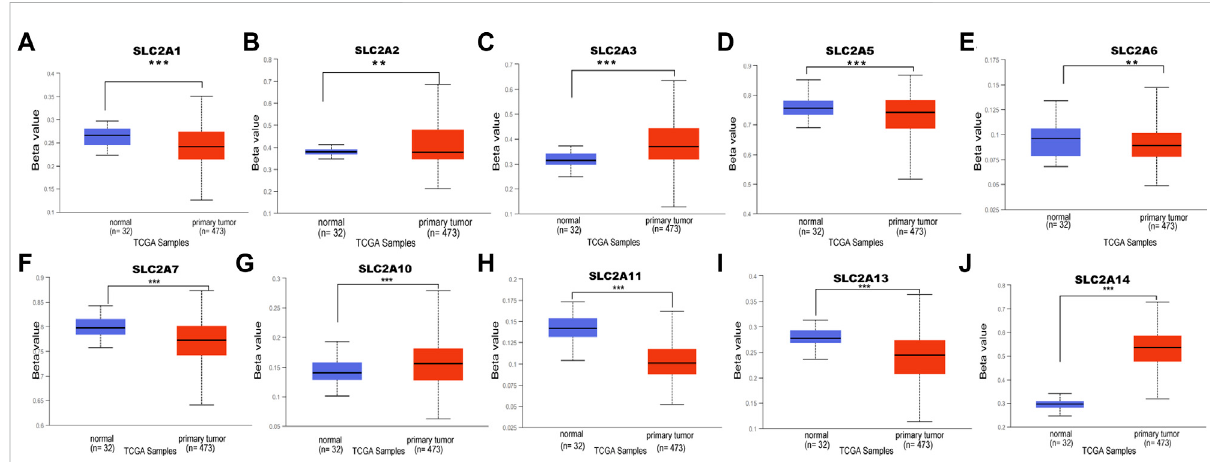
FIGURE 6 DNA methylation level of distinct SLC2As in LUAD tissues and adjacent normal lung tissues (UALCAN). Hypomethylation of SLC2A1 , SLC2A2 , SLC2A5 , SLC2A9 , SLC2A11 (A,B,D – F,H,I) andhypermethylationof SLC2A3 , SLC2A10 , SLC2A14 (C,G,J) werefoundinprimaryLUADtissuescompared with those in normal lung tissues. *** p < 0.001, ** < 0.01, * <